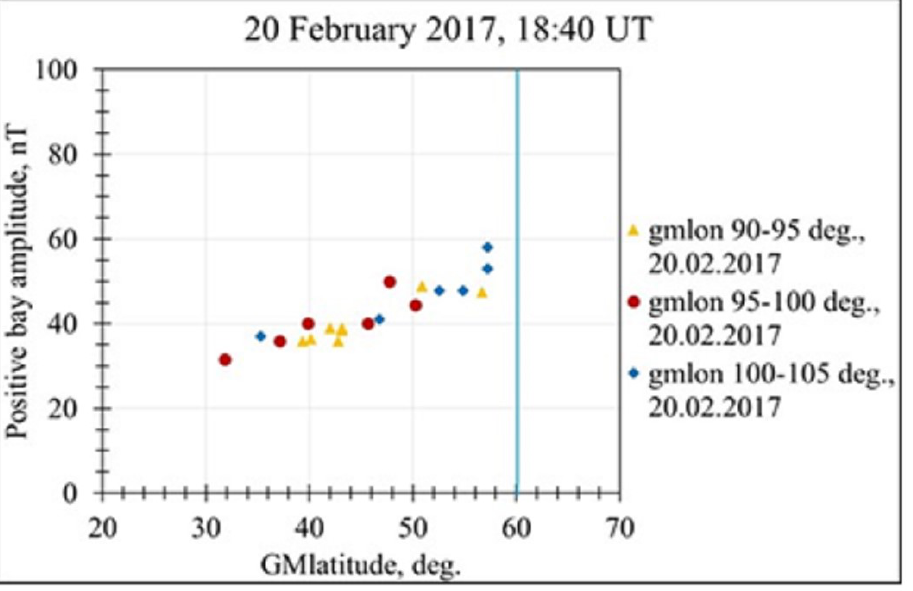
Fig.5. The dependence of magnetic positive bays (MPB) amplitude on the geomagnetic latitude for the substorms on 20 February 2017. The results for the examined longitudinal intervals are marked as follows: 90°-95° GMLon – by triangles, 95°-100° GMLon – by circles, and 100°-104° GMLon – by diamonds (shown in the right part of the